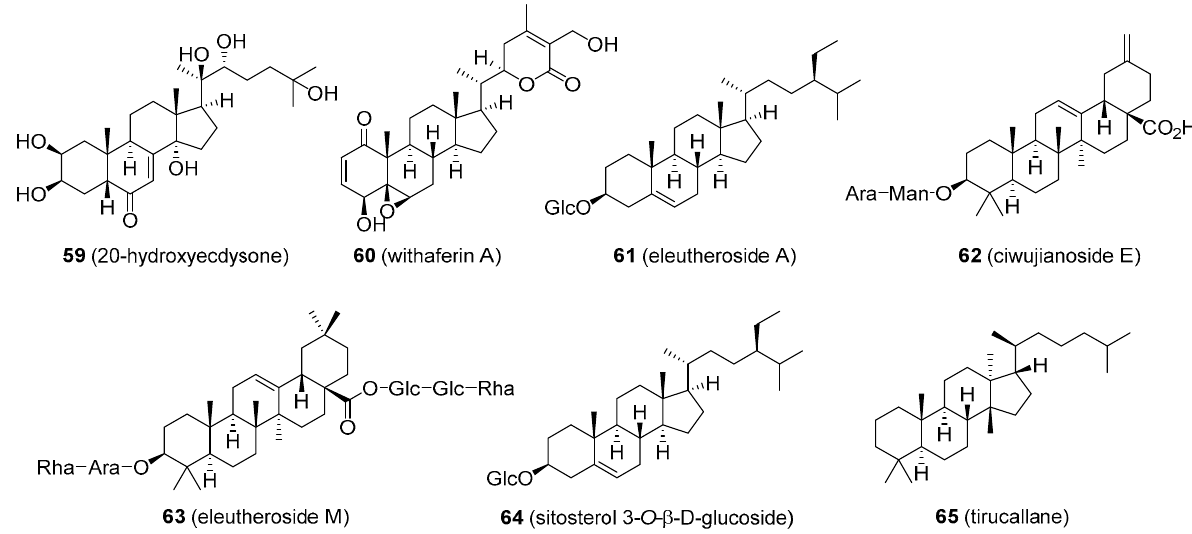
Figure 11. Plant-based steroids that are part of products marketed as testosterone boosters II.